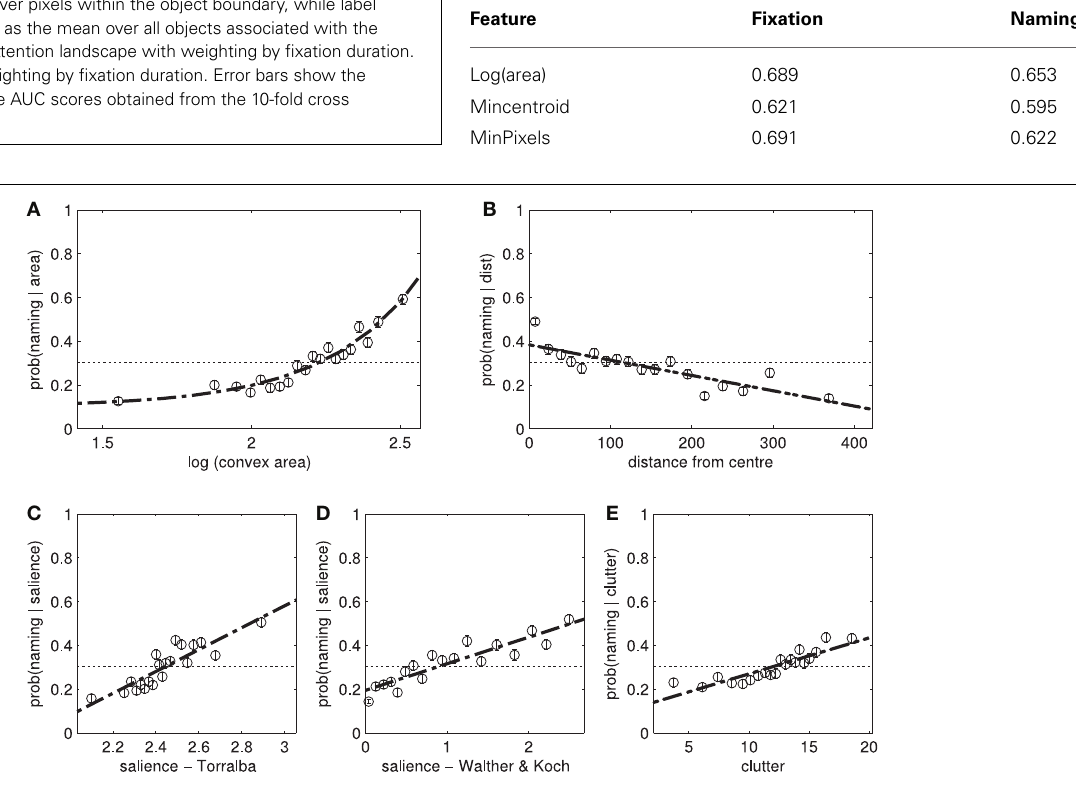
Table 4 | AUC scores for object area and distance from center.